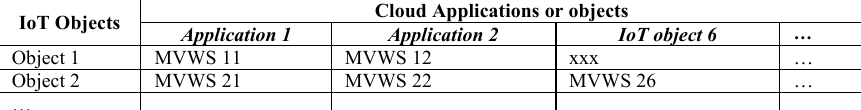
Table 1. Multi-view Object’s